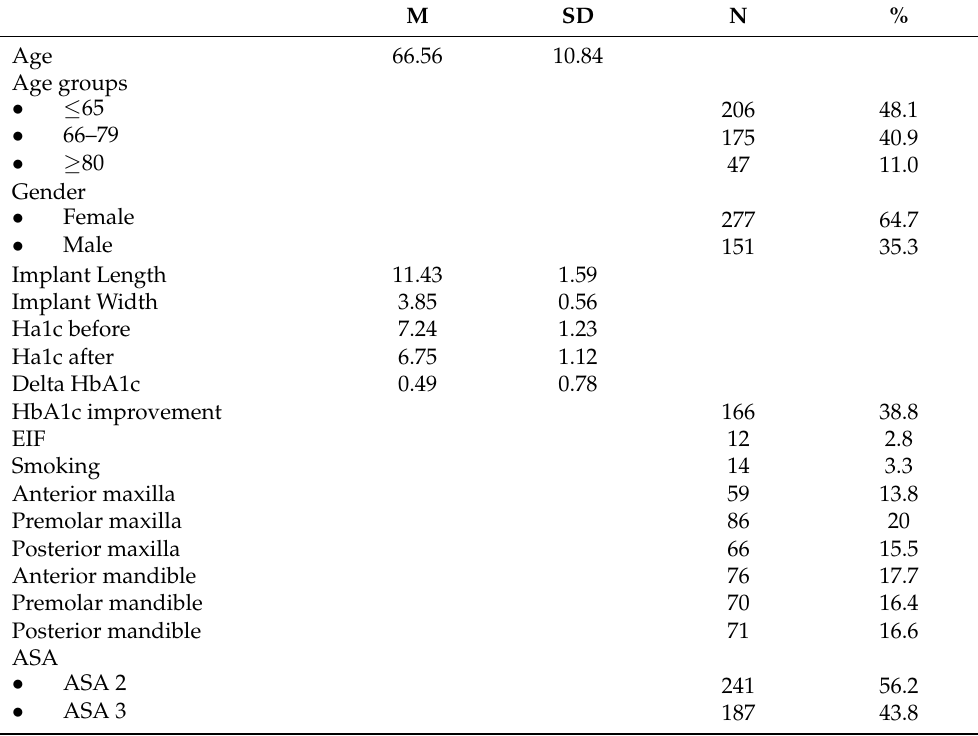
Table 4. Demographic and clinical characteristics (implant level, n =